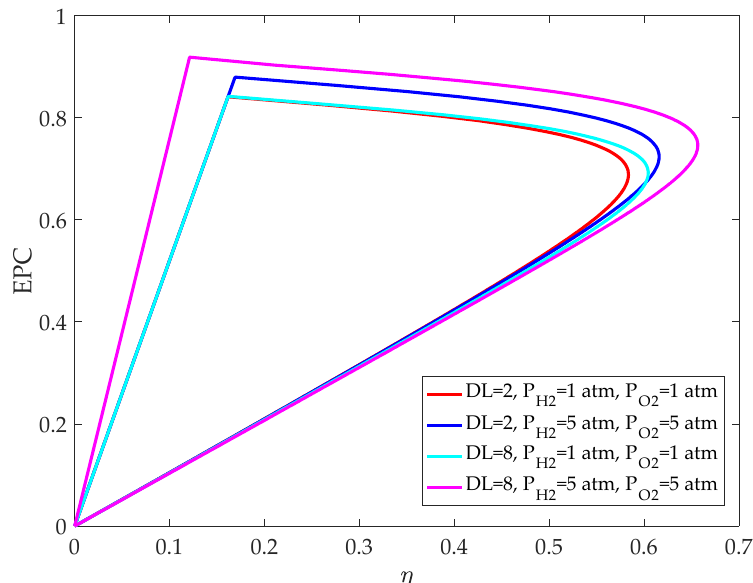
Figure 10. Exergetic performance coefficient versus energy efficiency before and after optimizing.